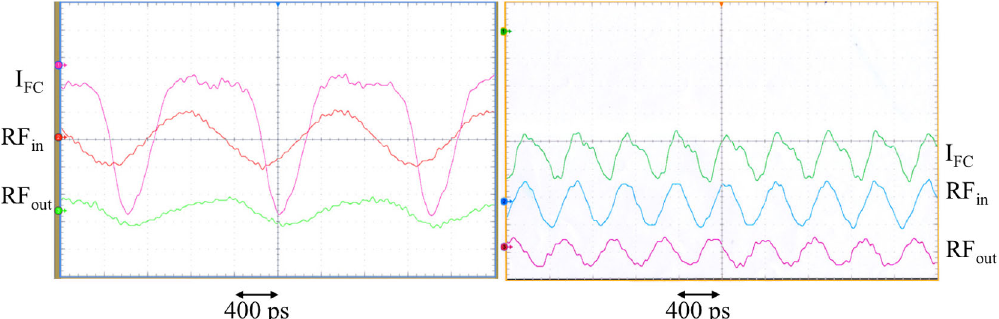
FIG. 4. Measured Faraday cup current ( I ) for single-frequency 714 MHz (left) and 2142 MHz (right) grid drive. For the left-hand FC ¼ (cid:2) 24 kV , V ¼ (cid:2) 90 V , and (cid:1) 100 W at 714 MHz producing a 408 ps FWHM ( (cid:1) 170 ps rms) data set, the parameters are V cathode grid micropulse with peak current (cid:1) 2 : 2 A and 0.9 nC per bunch. For the right-hand data set, the parameters are V ¼ (cid:2) 63 V , and (cid:1) 300 W at 2142 MHz, producing a peak current of (cid:1) 110 mA . The colored dot on the left axis associated with V grid each waveform shows the associated baseline of the trace. Also shown are the incident and reflected rf waveforms, rf